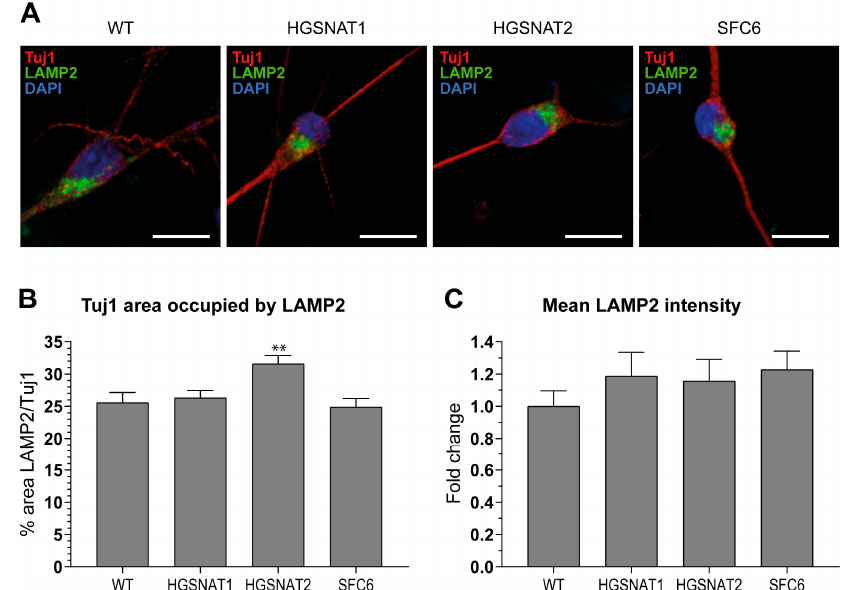
8 of 15 Figure 3. Representative images of differentiated iNs from all iPSC lines (WT, HGSNAT1, HGSNAT2, and SFC6) positive for Tuj1 (red) and MAP2 (green) and iAs from all iPSC lines positive for S100B (red) and VIM (green). Nuclei were detected with Hoechst (blue). Scale bar = 25 µm. 3.2. iNs and iAs Recapitulate Major Sanfilippo C Phenotypes Next, we sought to evaluate whether iNs and iAs derived from disease lines recapitulated main Sanfilippo syndrome phenotypes and would represent good cellular models of the disease. For that purpose, we performed two different experiments: LAMP2 immunocytochemical analysis to detect alterations in the lysosomal content of disease cells and HS quantification through UPLC-MS/MS to compare HS amounts between disease and healthy cells. LAMP2 has been extensively used as a marker for lysosomes. Using immunocytochemistry